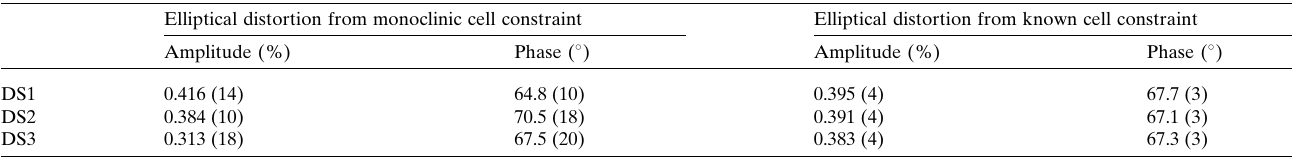
Table 8 Comparison of elliptical distortion parameters obtained from two different constraints: monoclinic symmetry of the unit cell and known unit-cell parameters from X-ray powder diffraction.